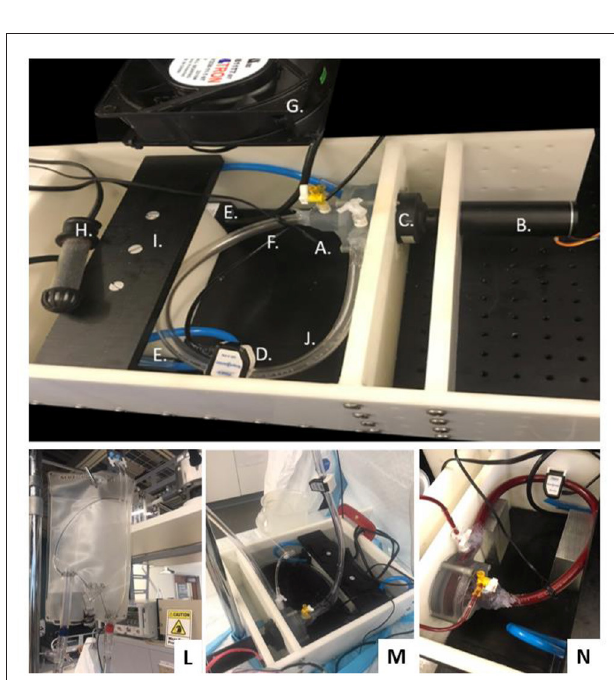
FIGURE 7 | Magnetically Levitated Centrifugal Pump for Hemolysis Testing: (A) Centrifugal Pump (Inlet Volute, Outlet Volute, Fluid Seal, Magnetic Drive Impeller and Ceramic Thrust Bearings), (B) Brushless DC Motor, (C) No Contact Diametrically Magnetized Cup Magnet, (D) Flow Sensor, (E) Heat Bath Circulation Pumps, (F) Waterproof Thermocouple, (G) Cooling Fan, (H) Heater, (I) Heath Bath Partition, (J) Heparin Coated Tubing, (K) Leur-Lok Fill and Draw Ports, (L) Commercial blood bag as supply reservoir, (M) Connected set-up, (N) Pump placement and filled test rig.